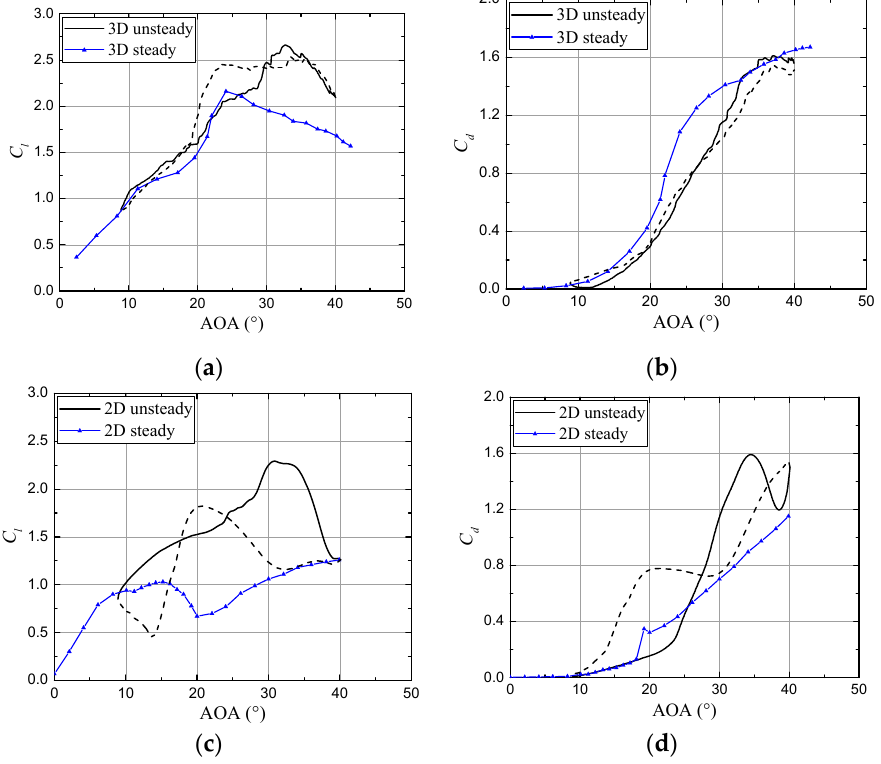
Figure 8. Hysteresis loops of the lift and drag coe ffi cients. r / R = 30%, V w = 13 m / s, and φ y = 30 ◦ . Solid lines denote increasing AOA, and dashed lines decreasing AOA. ( a ) 3D C l ; ( b ) 3D C d ; ( c ) 2D C l ; ( d ) 2D C d .